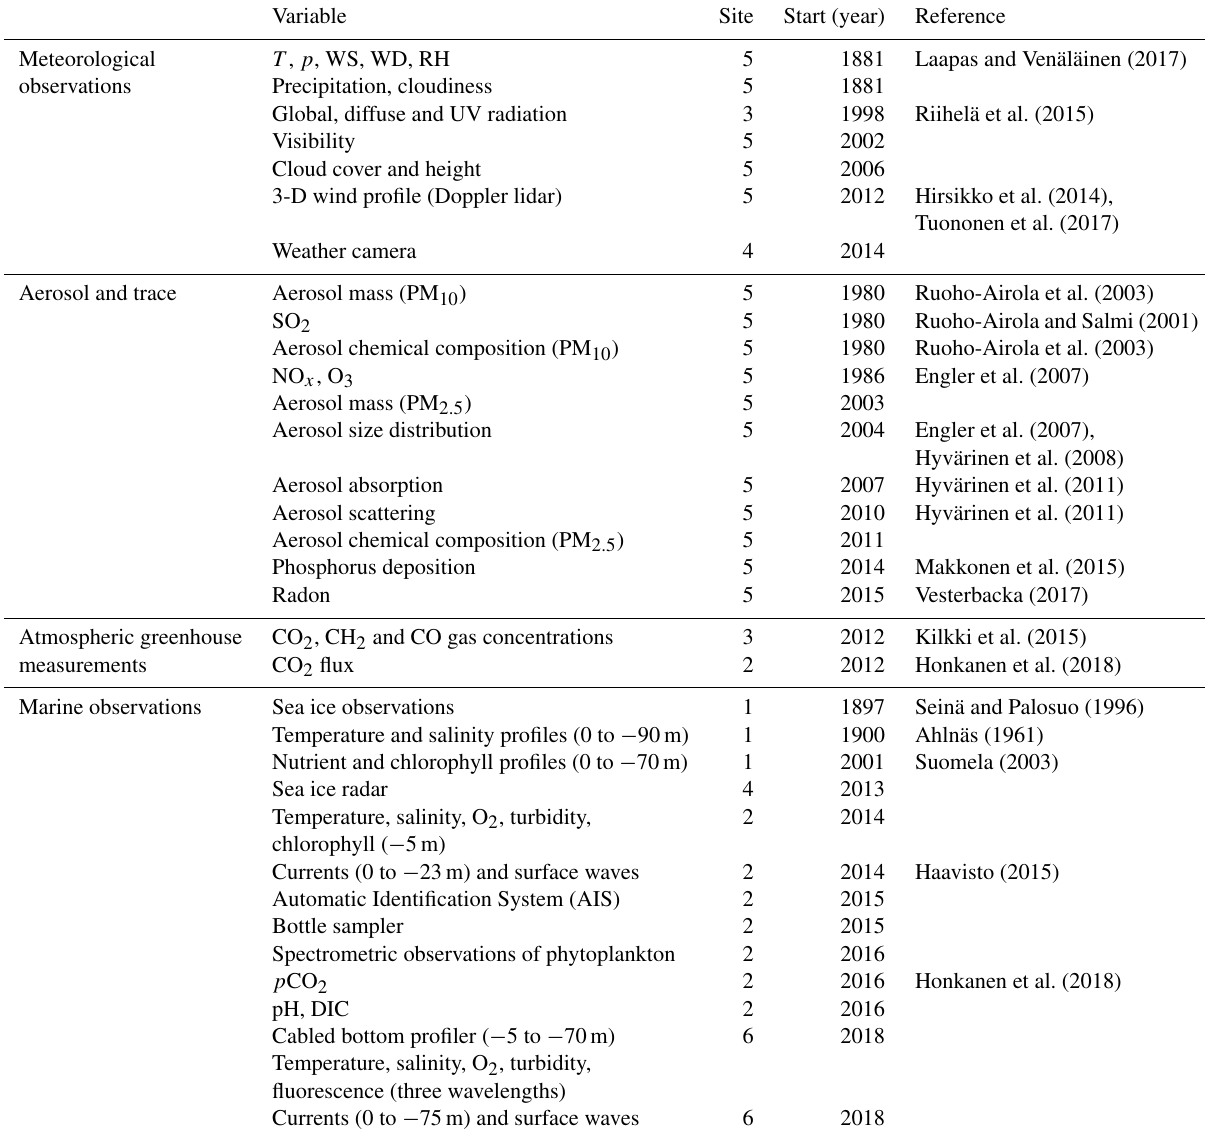
Table A1. Continuous atmospheric and marine observation at Utö. Site refers to numbers and coordinates in Fig.